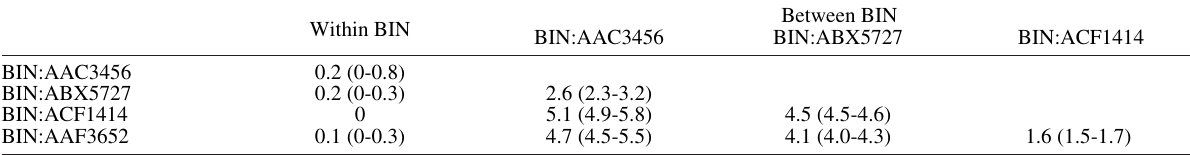
Table 4. – Genetic distances (% of p-distances) among COI sequences of kyphosid BIN (range values are shown in brackets). Within BIN